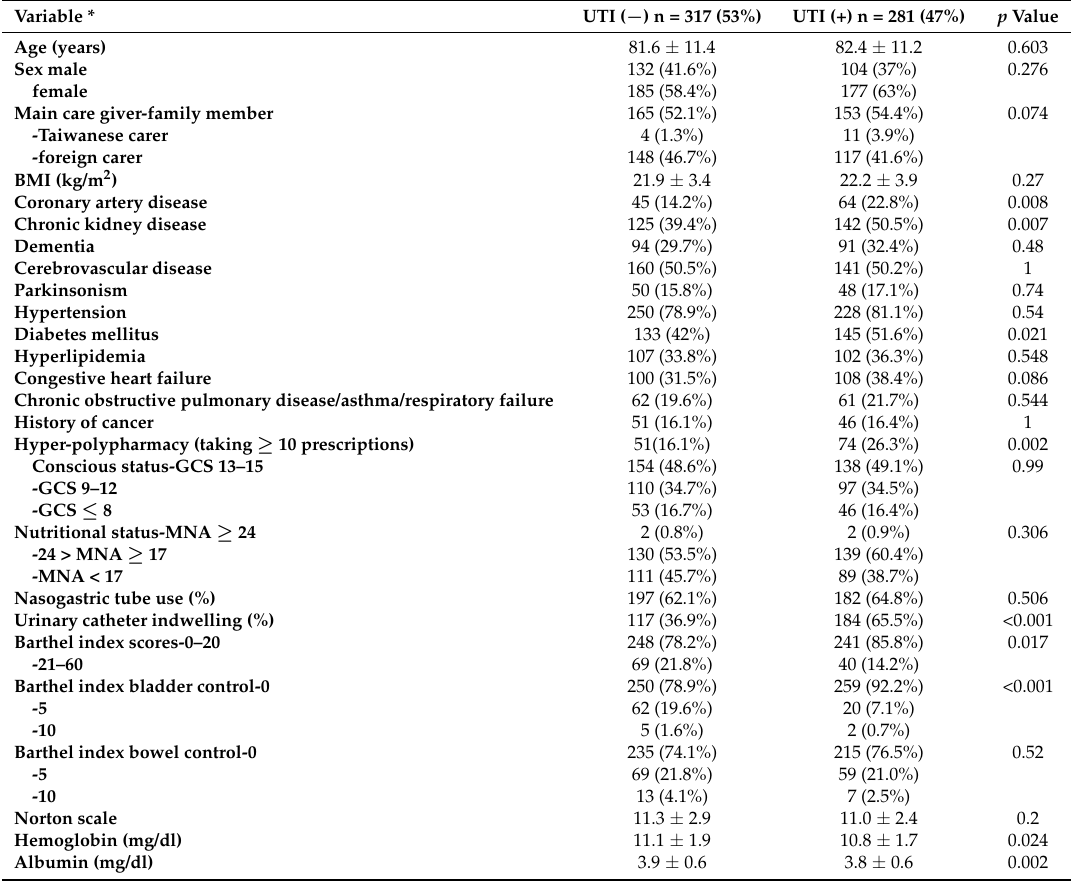
Table 2. Comparison of baseline characteristics between UTI # and non-UTI groups.